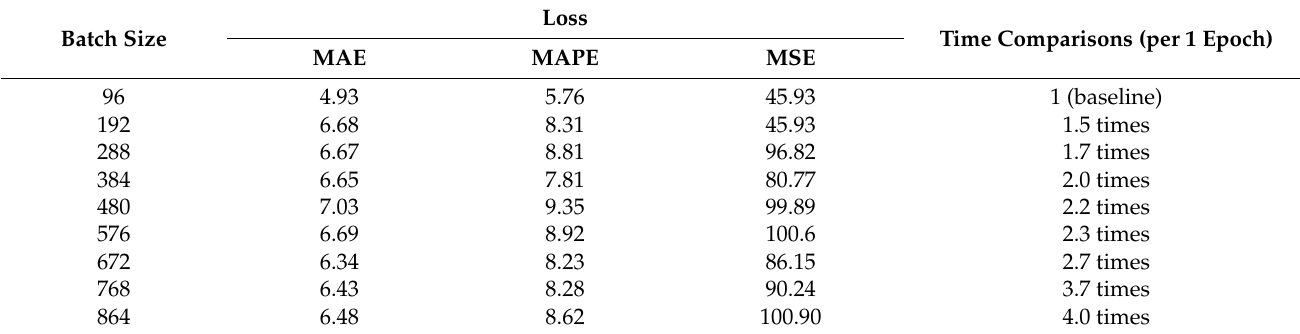
Table 1. Batch size